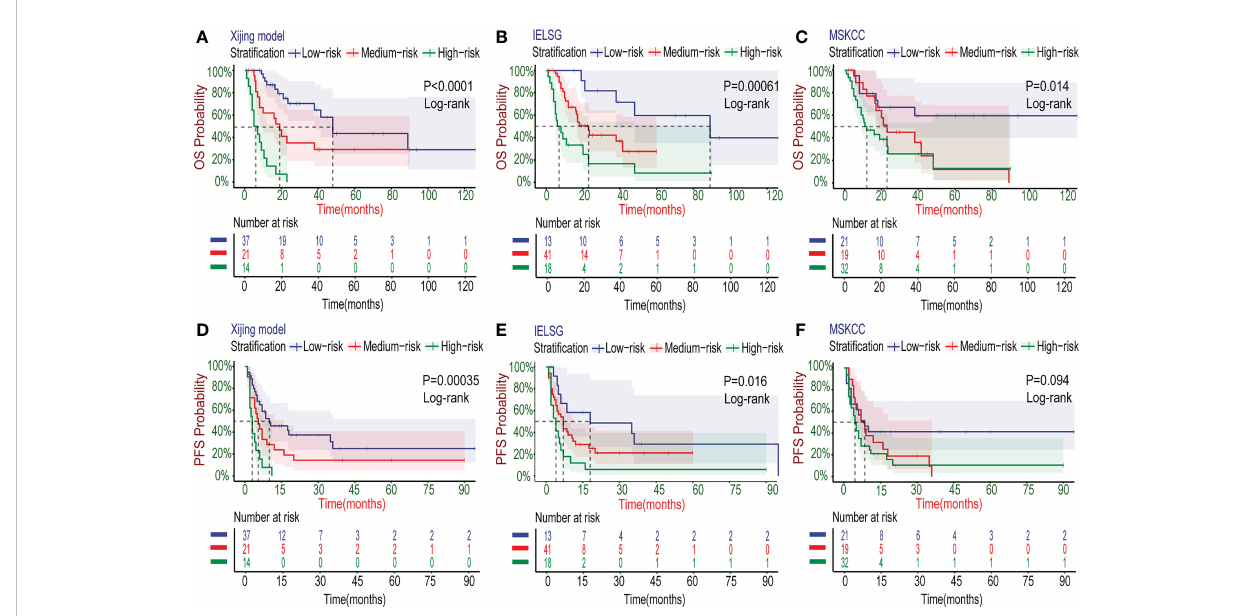
FIGURE 4 Kaplan – Meier survival curves in the development cohort. (A-C) For OS, the PCNSL patients were strati fi ed into three groups by the Xijing Model, IELSG and MSKCC prognostic scores. (D-F) The PFS was also classi fi ed by above three risk strati fi